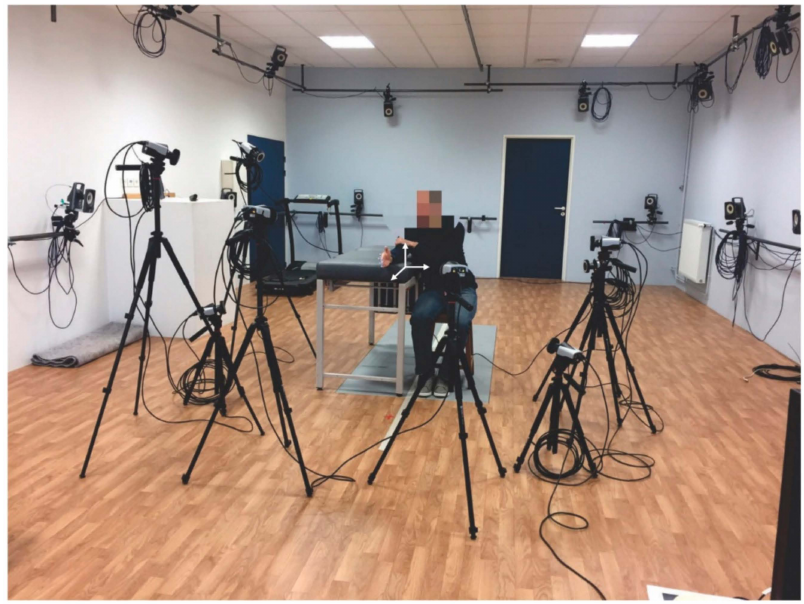
Figure 7. The experimental site with the Qualysis system. A set of 21 markers was used and installed on the right hand of each volunteer. Table 2 describes each marker’s location and the label that was used to reconstruct the hand in digital form. The digital reconstruction of the hand is shown in Figure 8. The digital reconstruction was based on marker locations following the anatomy of the subject. Table 2. Localization and names of the markers in the hand.